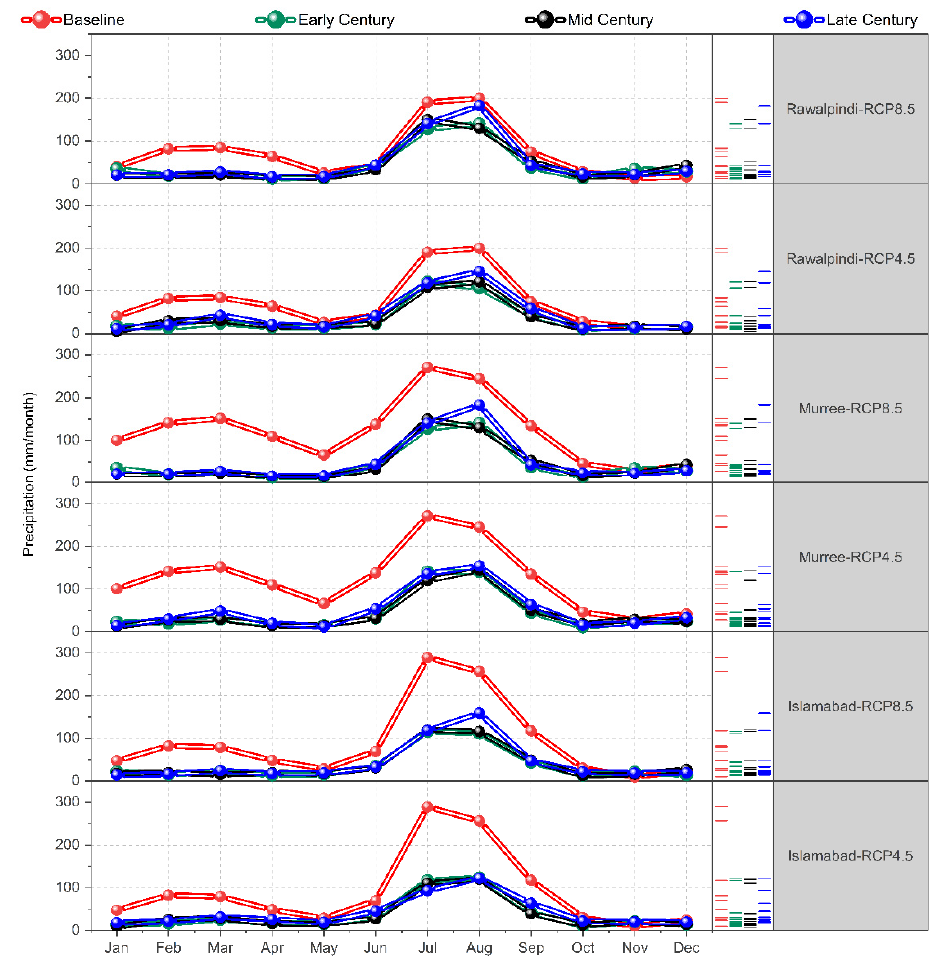
Figure 5. Monthly profiles of precipitations for the base line period, early, mid, and late century under RCP-4.5 and RCP-8.5 at selected stations.